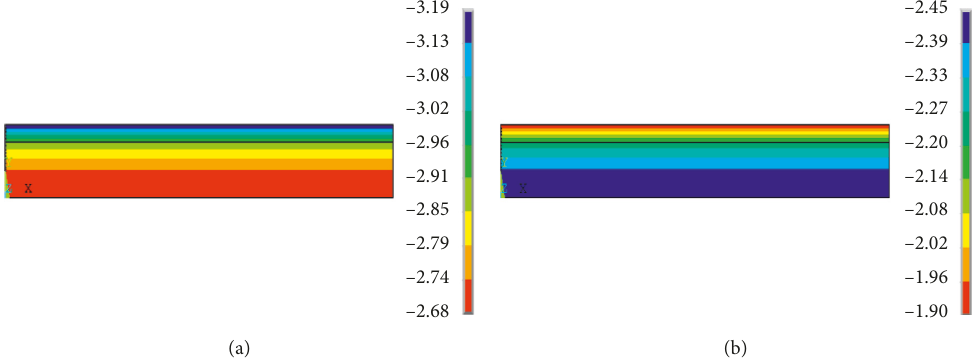
Figure 5: Surface temperature distribution ( ° C) of HSMP with insulating the bottom (a) at 6: 00 and (b) at 16: 00.